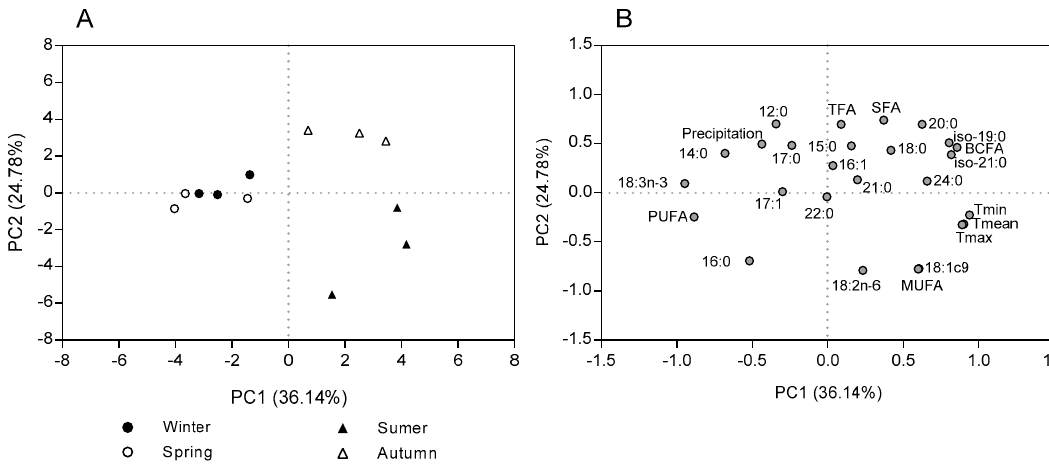
Figure 3. Scores ( A ) and loadings ( B ) of the two first PCs computed using the fatty acid content and composition of leaves, as well as data about temperature and precipitation among seasons.